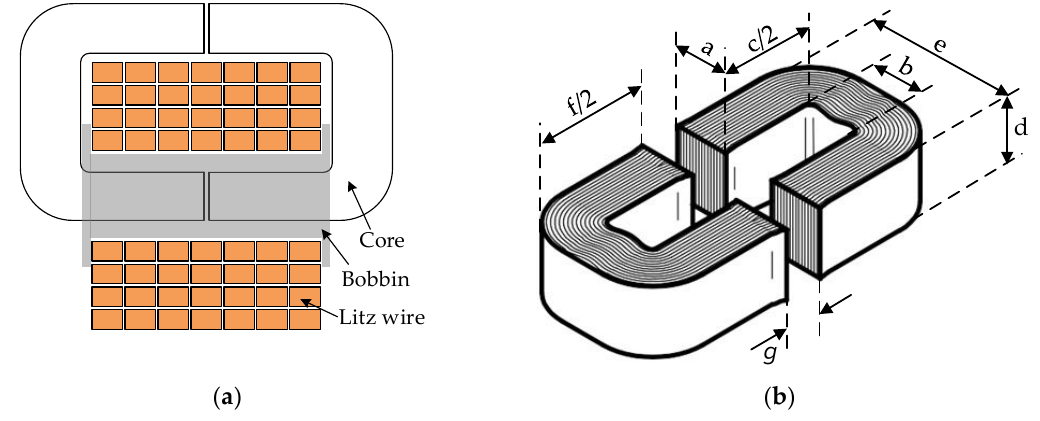
Figure 5. ( a ) Structure of an inductor; ( b ) Geometry parameters of a core.